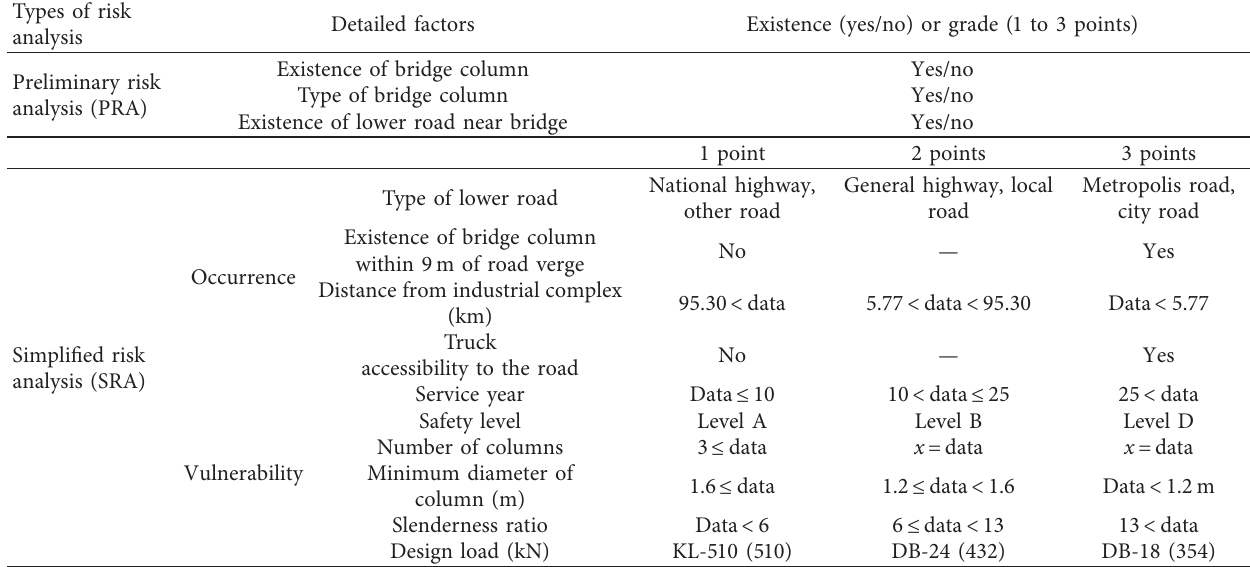
Table 2: Factors for risk